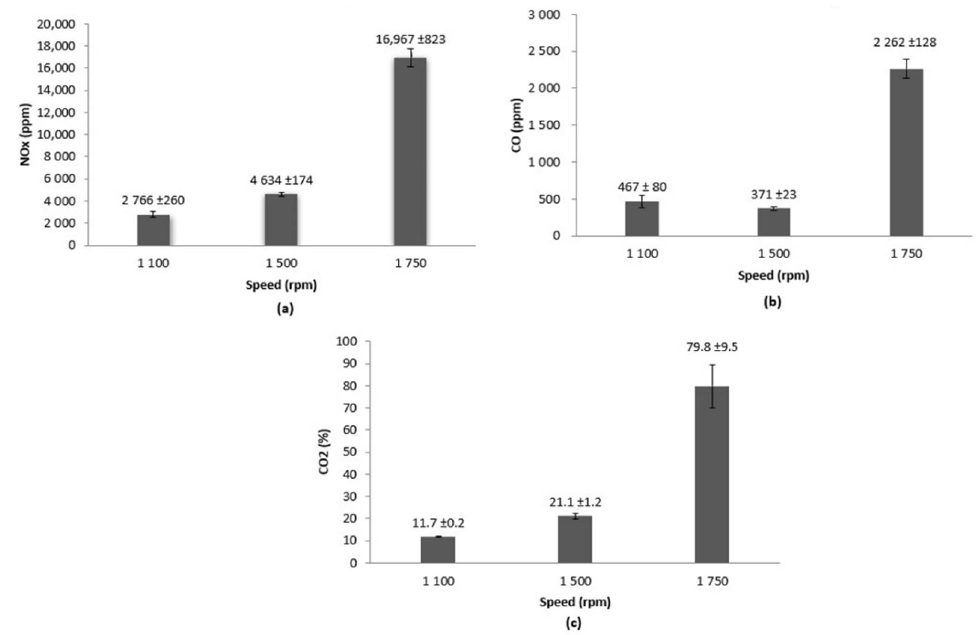
Figure 2. Exhaust gases by varying engine speed using B7: ( a ) NO X ; ( b ) CO; and ( c ) CO 2 .